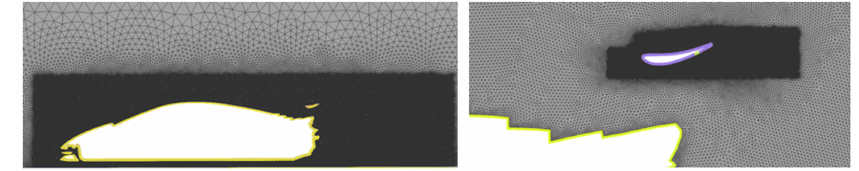
Figure 12. Geometry and computational mesh of the model of a vehicle with a